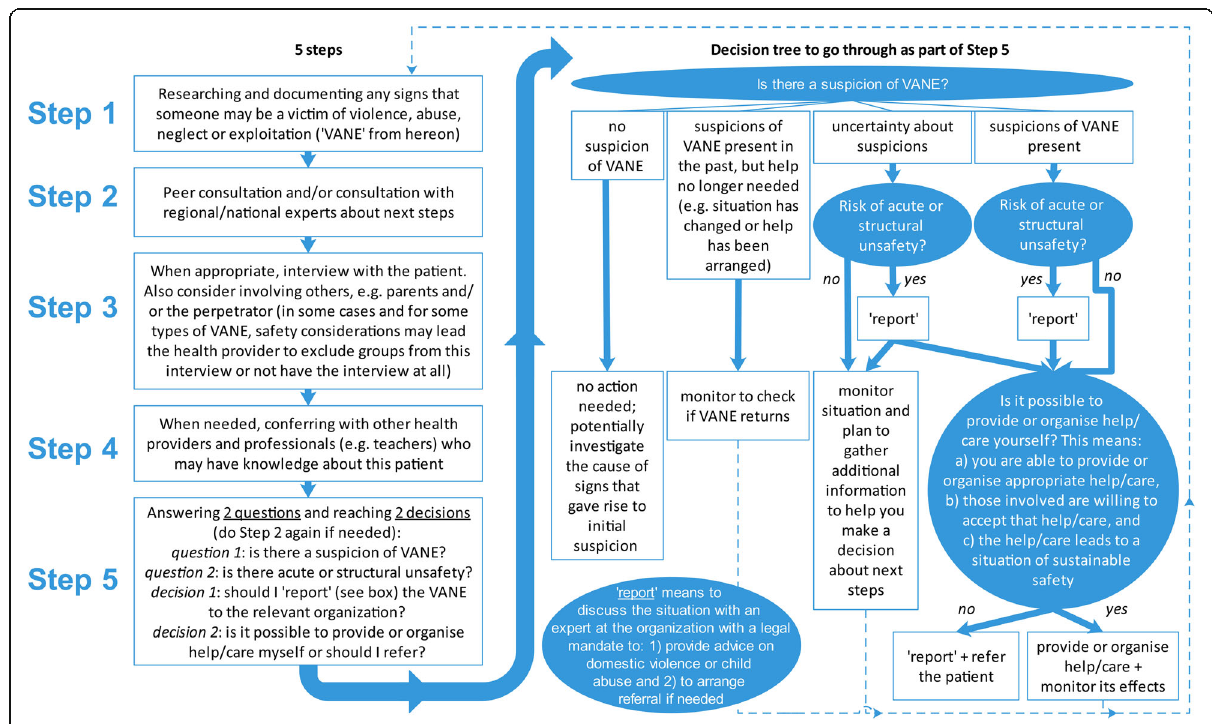
Fig. 1 Five steps for deciding how to respond as a health provider when you suspect someone is a victim of violence, abuse, neglect or exploitation (VANE). This figure is based on the identification, support and referral protocol in the Netherlands; [6 – 8] other countries may have their own protocols that may differ from the one described here. In the Netherlands, the organization with a legal mandate to 1) provide advice on domestic violence or child abuse and 2) arrange referral when needed, is “ Veilig Thuis ” , meaning “ Safe at Home ” . Whenever possible, ‘ reporting ’ should be done with the consent of the patient, but when the health provider is of the opinion there is acute and/or structural unsafety, he/she may be justified or even obligated to break confidentiality and report the situation to this organization against the wishes of the